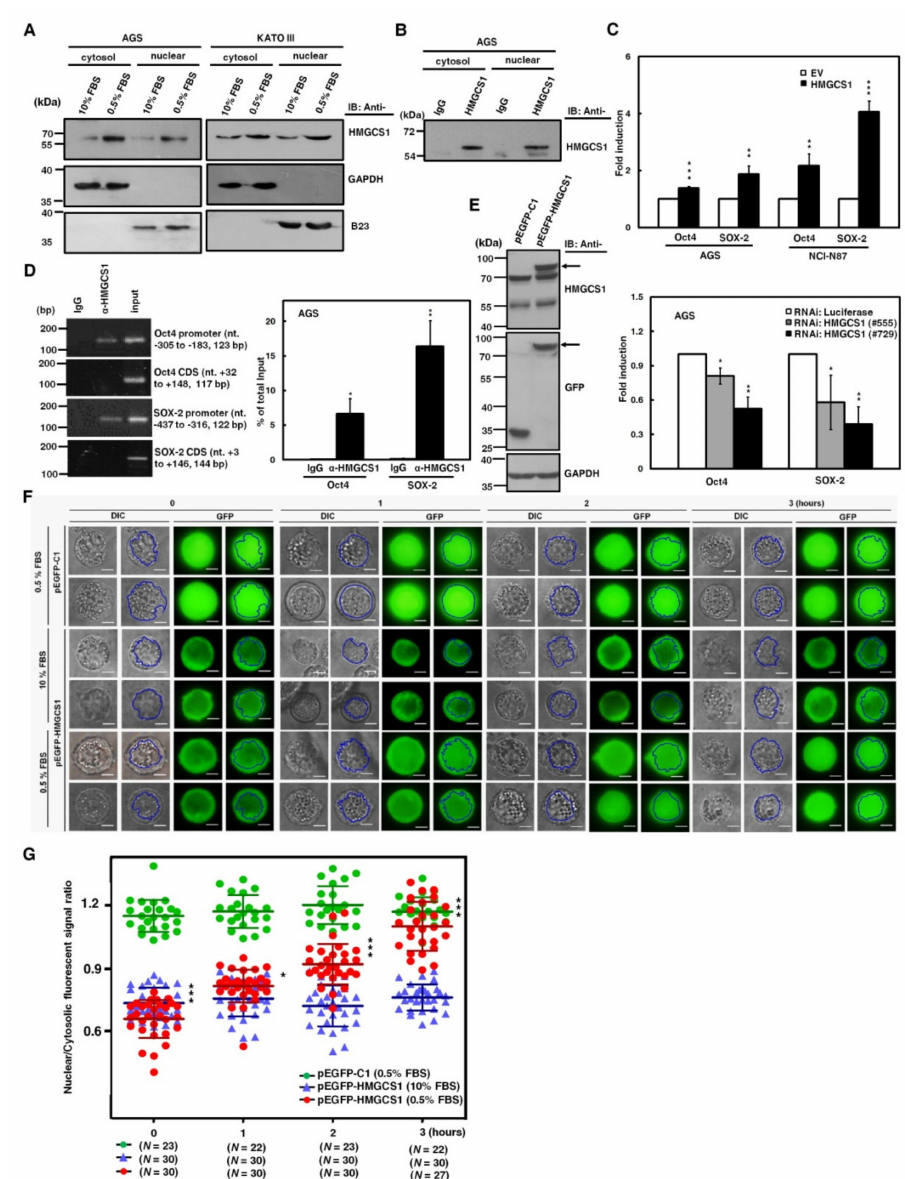
Figure 6. Nuclear HMGCS1 translocation of gastric cancer cells is induced by serum deprivation. ( A ) AGS (left) and KATO III (right) cells were cultured in complete media containing 10% fetal bovine serum (FBS) or under serum deprivation (0.5% FBS) for 24 h. Then cytosolic and nuclear extracts of the treated cells were prepared for Western blot analysis using the anti-HMGCS1, anti-GAPDH, and anti-B23 (a nuclear marker) antibodies. ( B ) Both cytosolic and nuclear extracts of AGS cells were immunoprecipitated with anti-HMGCS1 antibody. The precipitated proteins were then analyzed by Western blot analysis using anti-HMGCS1 antibody. ( C ) After co-transfection with the HMGCS1-expressing construct (HMGCS1) or empty vector (EV) and luciferase reporter plasmids containing promoters of pluripotency genes Oct4 or SOX-2 for 48 h, the transfected AGS and NCI-N87 cells were harvested for reporter gene assay (upper). After co-transfection with siRNA vectors against HMGCS1 (#555 and #729) or luciferase and reporter plasmids containing promoters of pluripotency genes Oct4 or SOX-2 for 48 h, the transfected AGS cells were harvested for reporter gene assay (lower). Mean ± SD ( n = 3). ( D ) AGS cells were harvested for chromatin immunoprecipitation (ChIP) assay using IgG or anti-HMGCS1 antibody. Then, the immunoprecipitated DNAs were used to amplify the PCR products using the primer pairs specific for the promoters and coding sequences (CDS) of Oct4 and SOX-2 (left). The positions (in relation to the transcription starting site) and lengths of